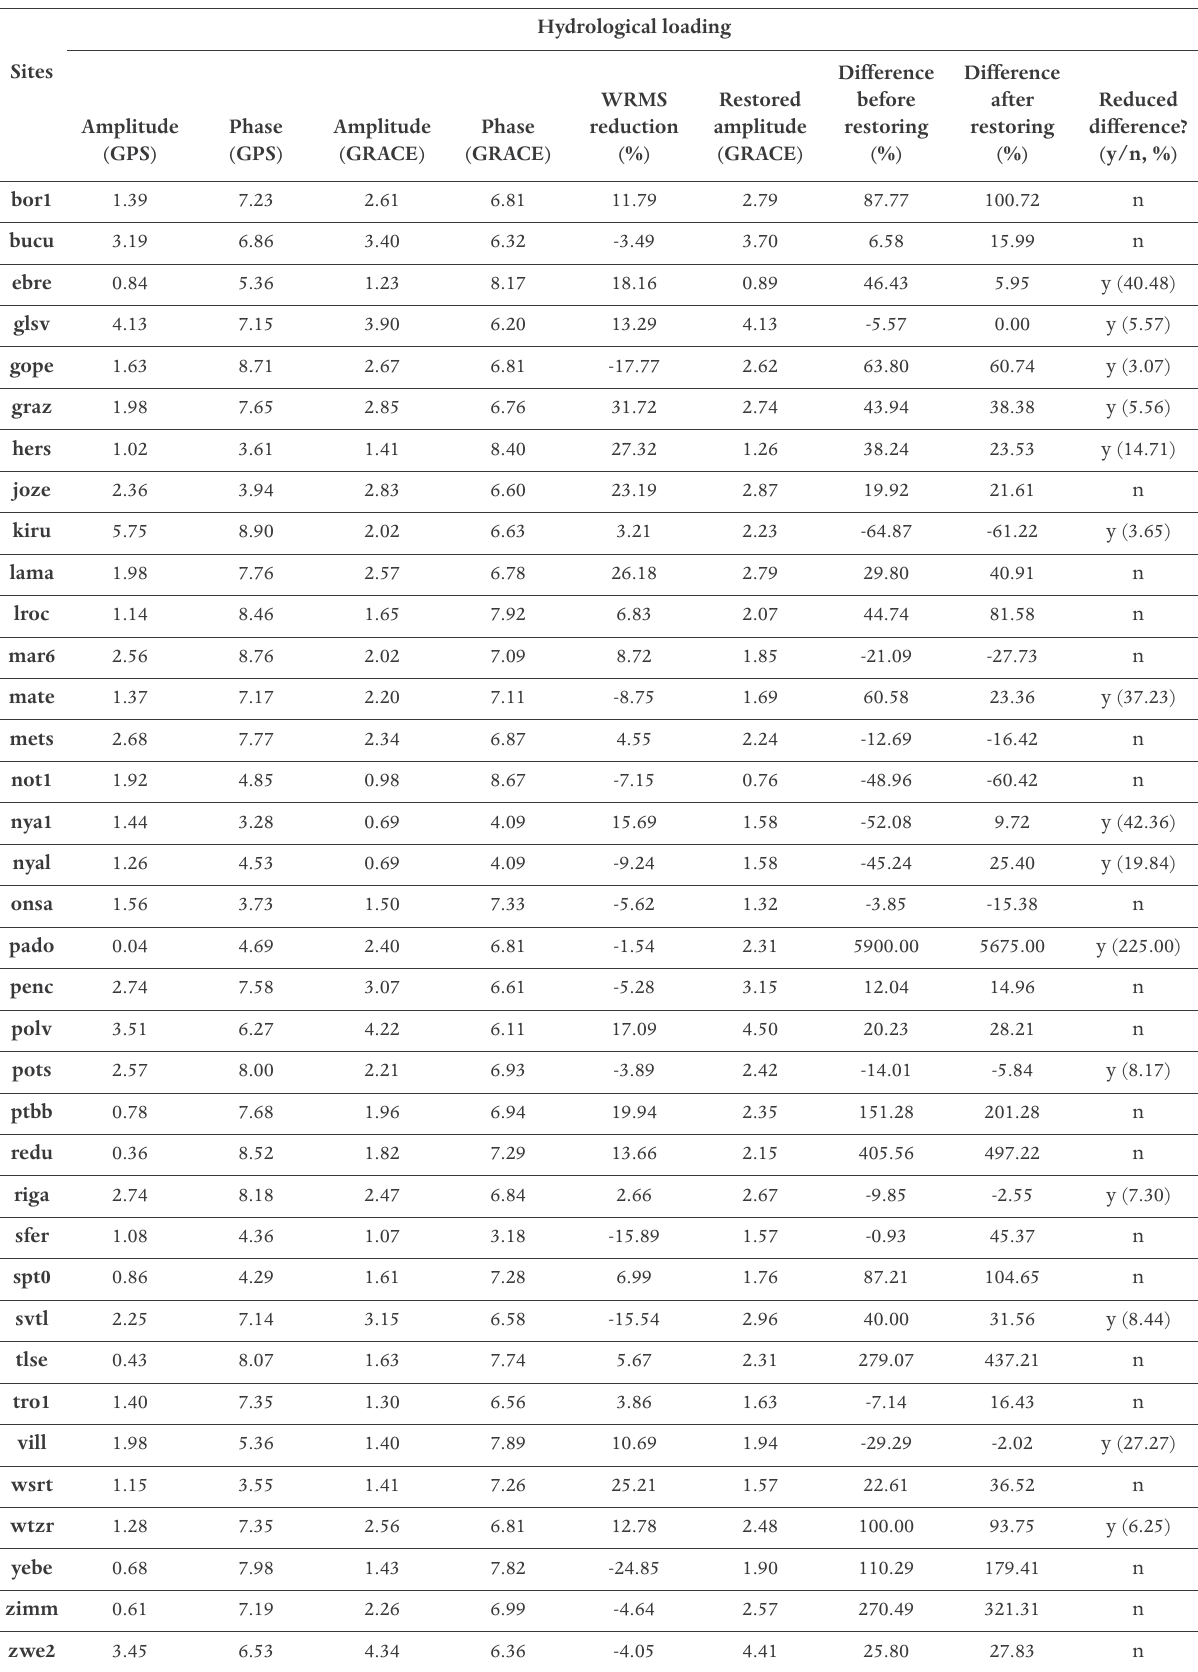
Table 1. Annual amplitudes and phases of GPS, GRACE and restored GRACE estimates, and their comparisons. (The annual amplitude A )+ { ], where t is 2002.0. Unit of amplitude is mm; unit of phase is month; column 8 = (column 4 − and phase { are defined as A sin[2 r ( t − t 0 0 column 2) ÷ column 2×100%; column 9 = (column 7 − column 2) ÷ column 2×100%; if |column 9| < |column 8|, mark “y” and compute |column 8| − | column 9| in column